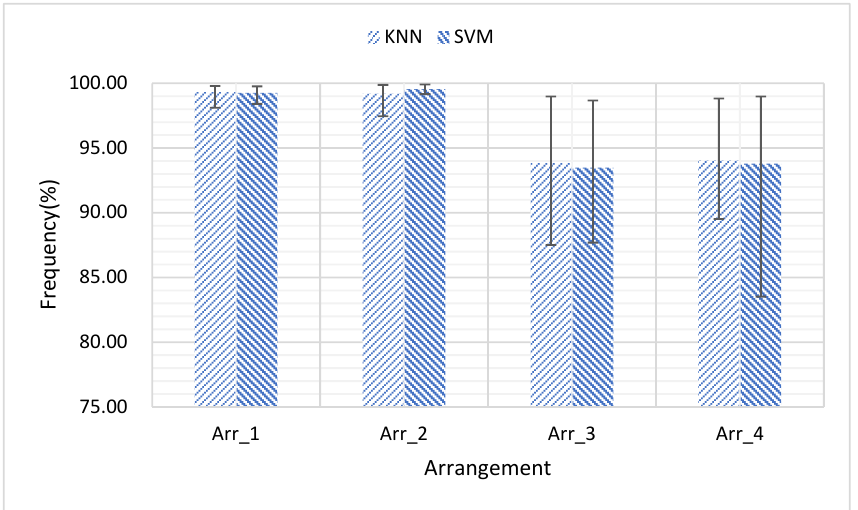
Figure 8. When selecting four channels in four types of arrangement, the classification accuracy is compared. Arr_1 indicates the selection of channel 1, channel 5, channel 9 and channel 13. Arr_2 indicates the selection of channel 3, channel 7, channel 11 and channel 15. Arr_3 indicates the selection of channel 2, channel 6, channel 10 and channel 14. Arr_4 indicates the selection of channel 4, channel 8, channel 12 and channel 16. The numbering of the channels is shown in Figure 5d.